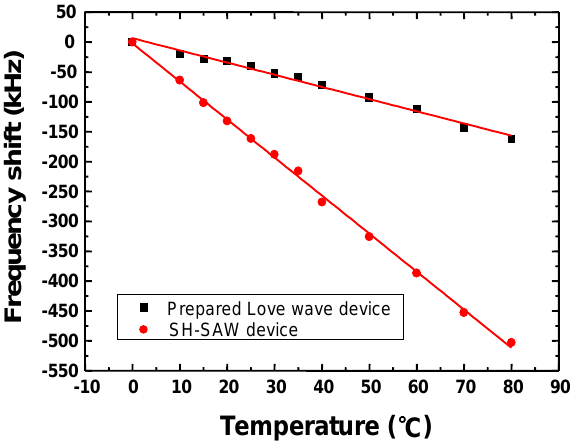
Figure 7. The measured temperature stability of the Love wave device.